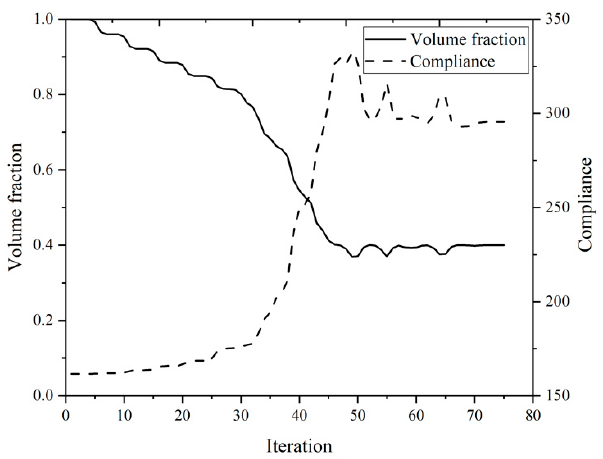
Figure 10. Convergence history of C-shaped bracket by hole nucleation method.